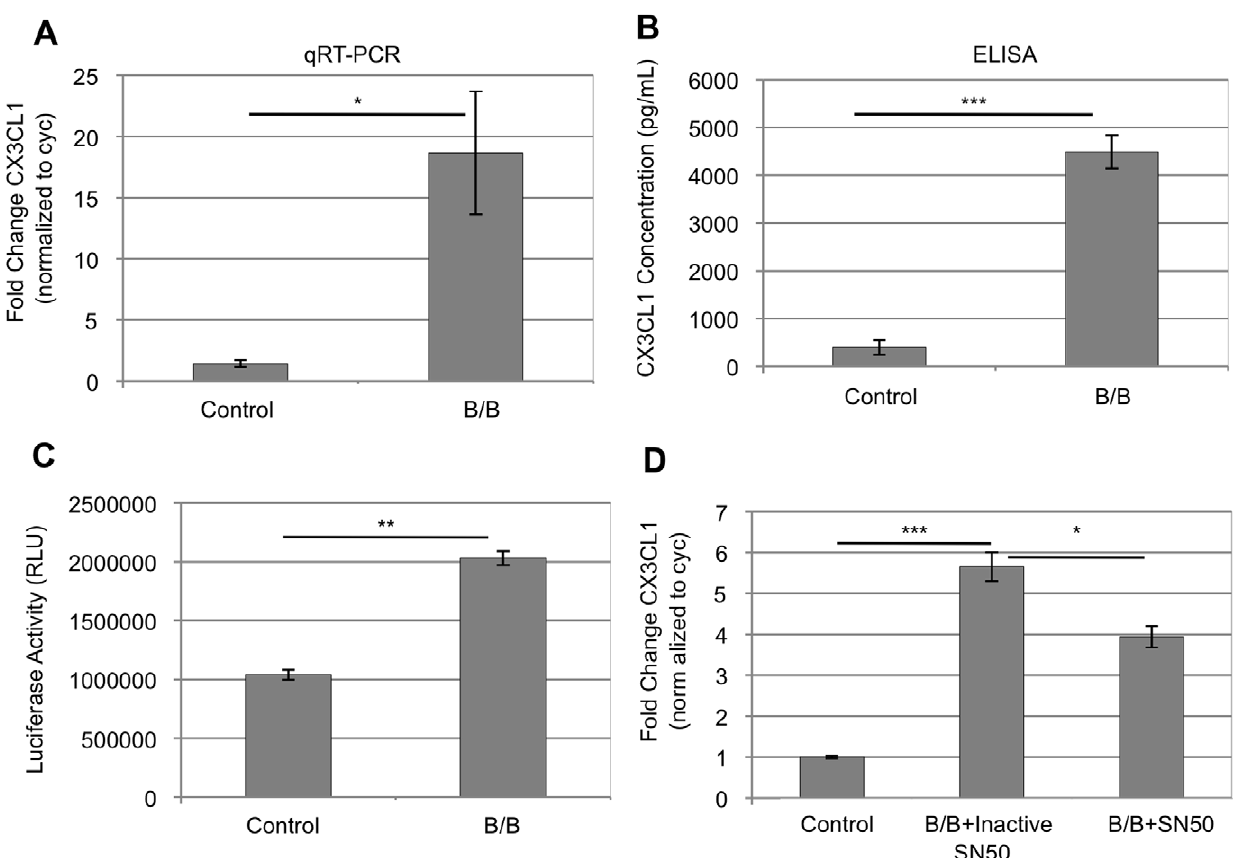
Figure 2. iFGFR1 activation induces secretion of CX3CL1 via the NF k B pathway. Treatment of HC-11/R1 cells with B/B induces production and secretion of CX3CL1. A) CX3CL1 gene expression was induced after 4 hours of B/B treatment as determined by qRT-PCR analysis. CX3CL1 levels were normalized to cyclophilin. B) ELISA analysis demonstrated that CX3CL1 is secreted by HC-11/R1 cells after 24 hours of B/B treatment. C) Treatment of HC-11/R1 cells with B/B for 6 hours increased the transcriptional activity of NF k B as measured by luciferase assay. D) Treatment of HC- 11/R1 cells with the NF k B inhibitor peptide SN50 in conjunction with B/B significantly reduced CX3CL1 transcript levels as measured by qRT-PCR in comparison to HC-11/R1 cells treated with inactive SN50 in the presence of B/B demonstrating that iFGFR1-induced CX3CL1 is mediated by NF k B signaling. *p , 0.05, **p , 0.001, ***p , 0.0001. Results in each figure panel are representative of a minimum of three different experiments. Error bars represent